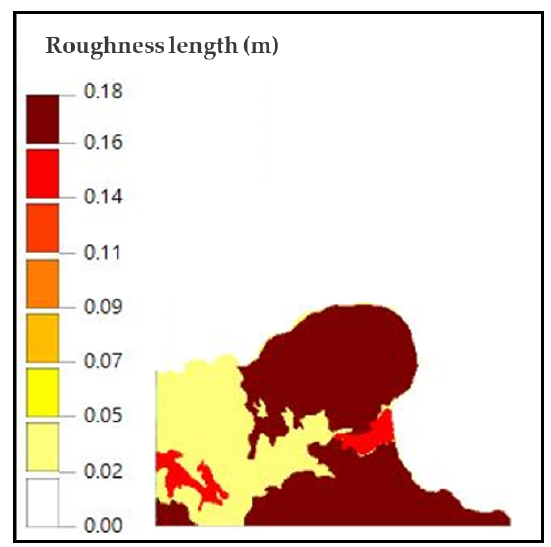
Figure A3. Roughness map of Wetar Island.